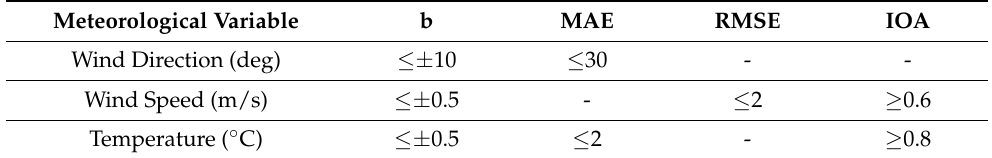
Table A1. Statistical Benchmarks for Evaluating Model Performance.